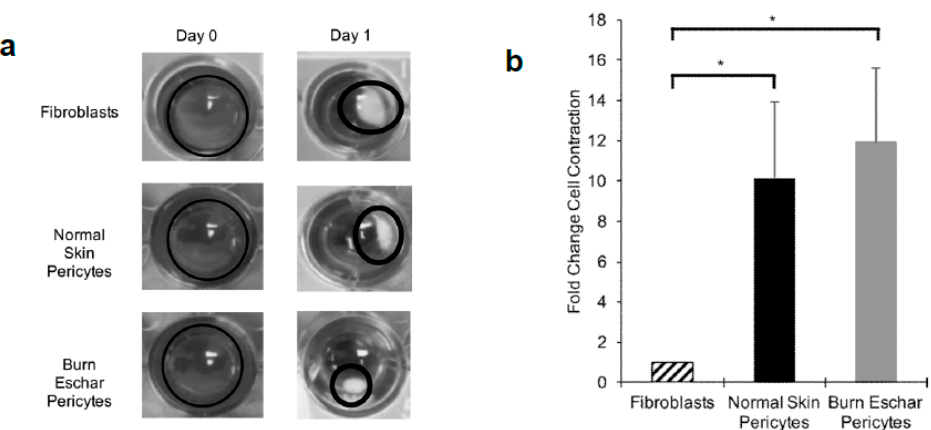
Figure 8. Burn eschar pericytes display increased cellular contractility. ( a ) Collagen contraction assay between fibroblasts and pericytes isolated from normal skin and burn eschar. Cellular contractile ability of normal skin pericytes and burn eschar pericytes was compared to normal skin-derived fibroblasts. Shown here is the representative images of three independent experiments performed in triplicate. ( b ) Quantitative analysis of contracted collagen lattice normalized to the average area of contraction seen in fibroblasts, set as a baseline value of 1. Each data point represents the mean ± SEM of the averages of triplicate reads for each culture derived from the three different patient samples. Statistical significance was determined using one-way ANOVA. * p < 0.05. Data indicates that burn eschar pericytes have a greater contractile capability than fibroblast.